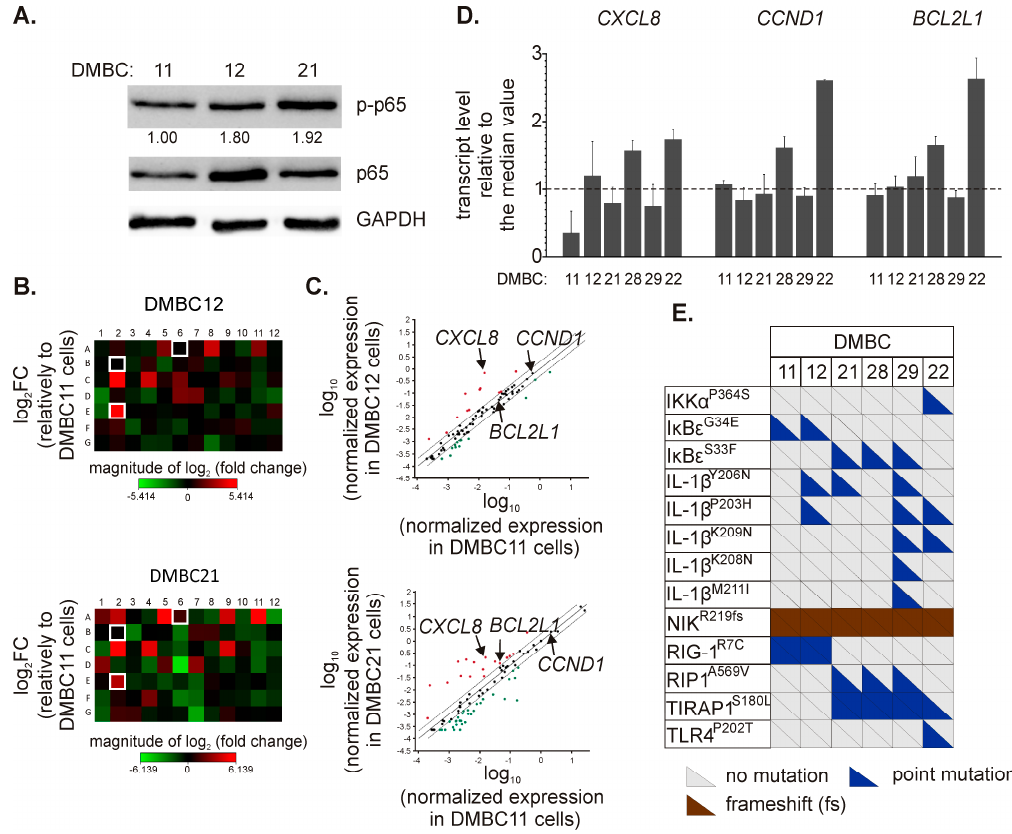
Figure 1. Diverse execution of nuclear factor-kappa B (NF- κ B)-dependent program in melanoma cell lines. ( A ) Levels of phosphorylated (p-p65) and total p65 were determined by Western blotting. Glyceraldehyde-3-phosphate dehydrogenase (GAPDH) was used as a loading control. The mean relative level of p-p65 versus GAPDH is shown ( n = 3). ( B ) Heatmaps were prepared to visualize differentially expressed NF- κ B-dependent genes. The relative mRNA levels in DMBC12 and DMBC21 cells were obtained by normalization to their levels in DMBC11 cells. Each fold-change (FC) value was log 2 -transformed. The array layout is shown in Table S1. The genes selected for further experiments are white framed. ( C ) Scatter plots were obtained by log 10 normalization of gene expression. Upper and lower bounds were set for a 2-fold change in mRNA levels. Upregulated genes are shown in red, and downregulated genes are shown in green. Detailed data are shown in Table 1. ( D ) The basal transcript levels of C-X-C motif chemokine ligand 8 ( CXCL8 ), cyclin D1 ( CCND1 ), and BCL-2-like 1 ( BCL2L1 ) in different melanoma cell lines of both BRAF V600E and NRAS Q61R subtypes were assessed by quantitative real-time polymerase chain reaction (qRT-PCR) and expressed relative to the median values in all six cell lines. ( E ) Color-coded diagram of mutations in genes assigned to the NF- κ B signaling (based on the KEGG PATHWAY database). Only indels and point mutations with damaging PolyPhen-2-based predictions are shown. Each triangle represents a single allele. Detailed data and non-mutated genes are included in Table S2.